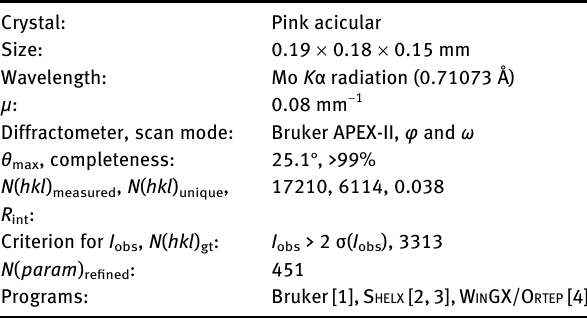
Table  : Data collection and handling.